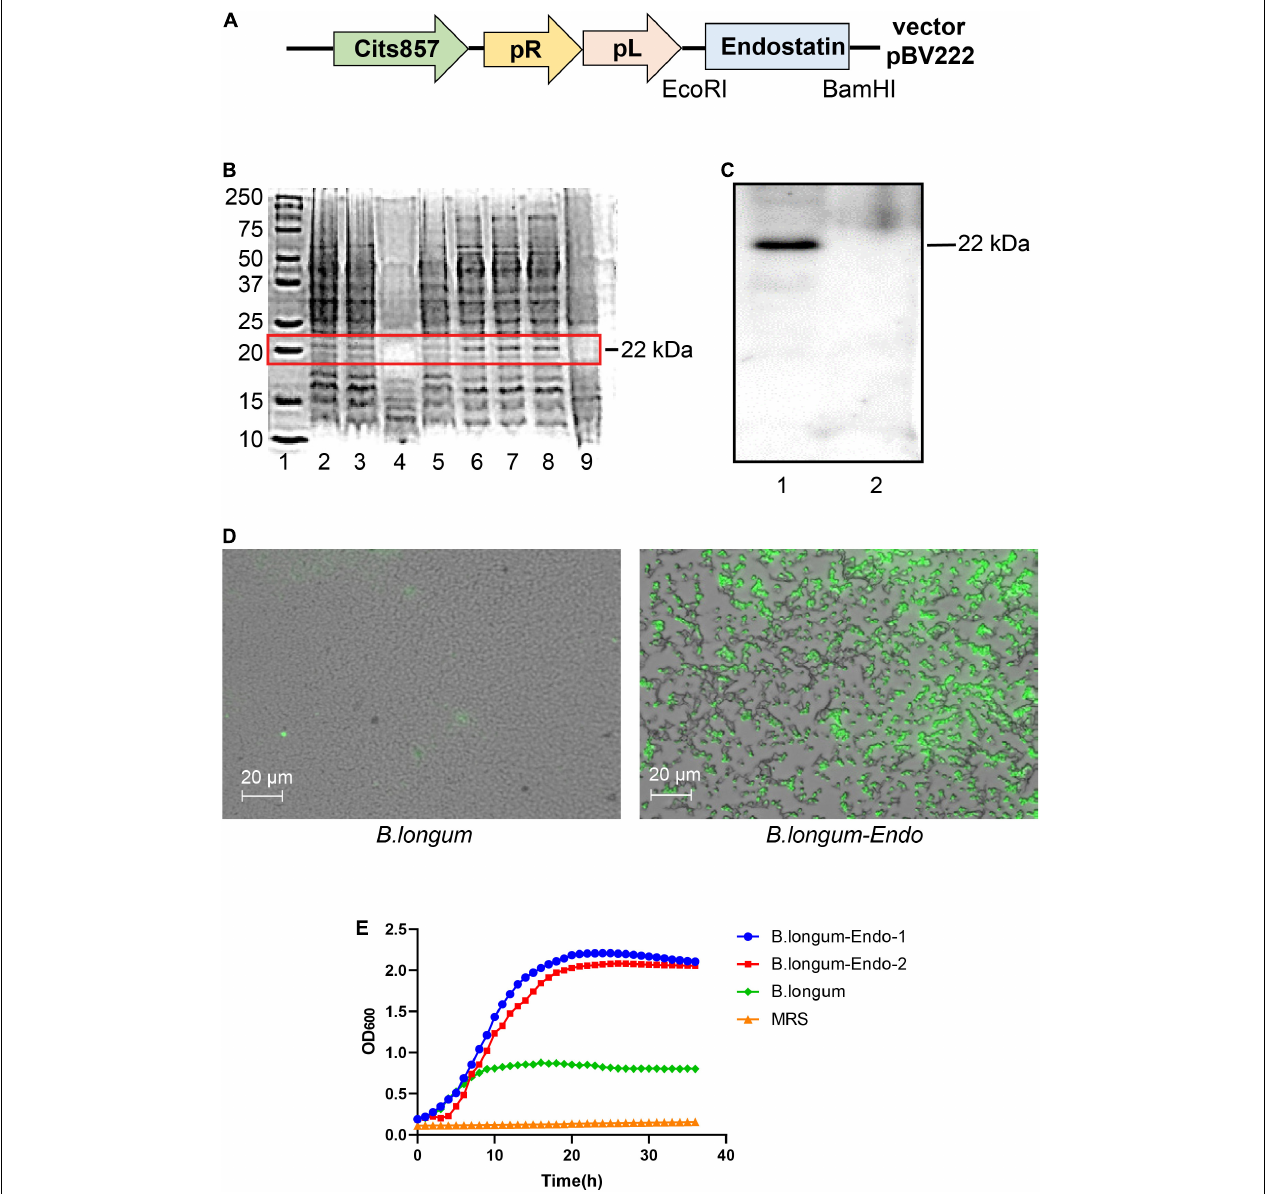
FIGURE 1 | Cloning and expression of endostatin in Bifidobacterium longum . (A) Schematic representation of expression cassettes for controlled and targeted endostatin production in B. longum . (B) Expression of endostatin in probiotic strains. Lane 1: Protein marker; Lanes 2–3: L. lactis-Endo ; Lane 4: L. lactis ; Lane 5: L. acidophilus ; Lane 6: L. acidophilus-Endo ; Lanes 7–8: B. longum-Endo ; and Lane 9: B. longum . (C) Expression of endostatin in B. longum . Lane 1: B. longum-Endo ; Lane 2: B. longum. (D) Detection of endostatin protein expression in B. longum by immunofluorescence staining. (E) The growth curve of the recombinant strain was measured with the wild strain and MRS solution as